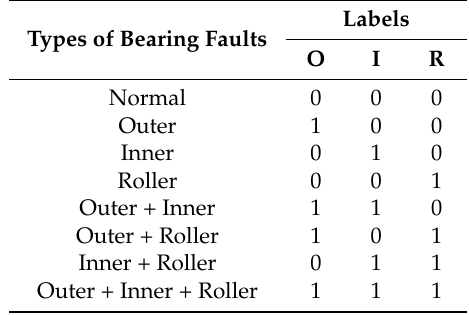
Table 1. Encoding the output label of DNN.